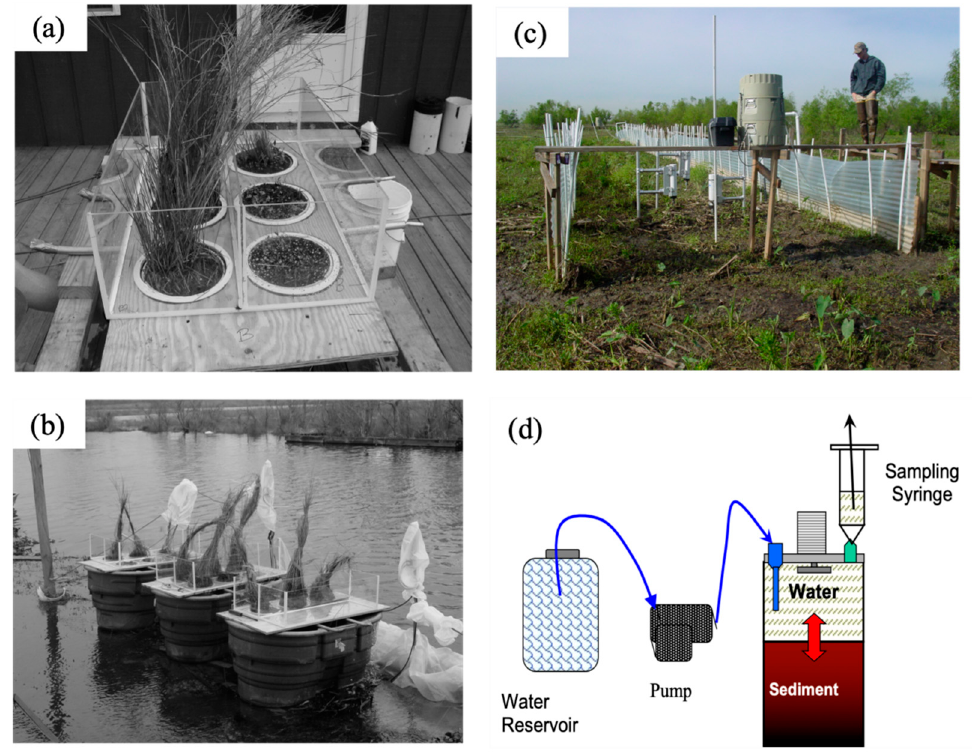
Figure 3. ( a ) Top view photos of marsh flux chambers used to measure intertidal benthic fluxes. ( b ) Full view of three chambers, with cores mounted, placed in large cooling tanks for incubation. ( c ) The marsh flume design to study nutrient exchange. ( d ) Schematic of the flow-through system used to measure subtidal benthic flux of nutrients in Breton Sound (after [38]).